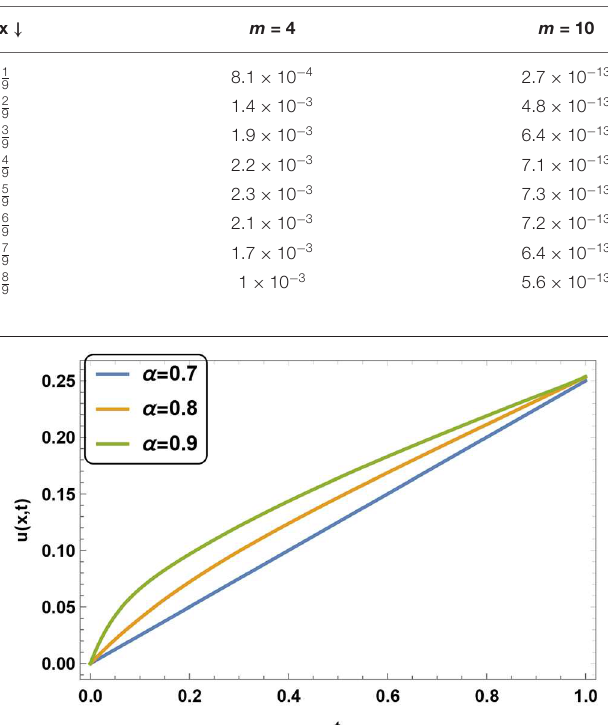
TABLE 1 | Deviation of absolute error at time t = 0.1.